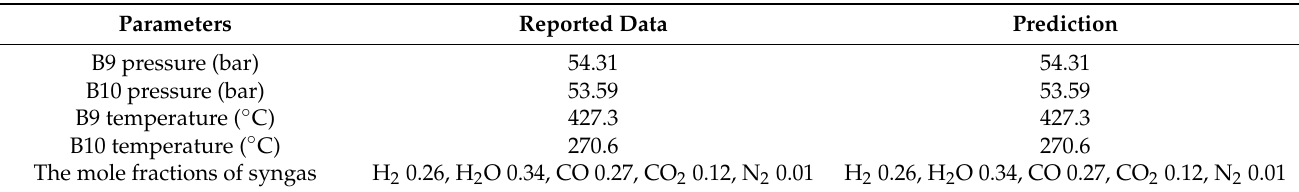
Figure 2. A schematic of the SHIFT module flowsheet. Table 1. Comparison of subunit forecasts with reported data of